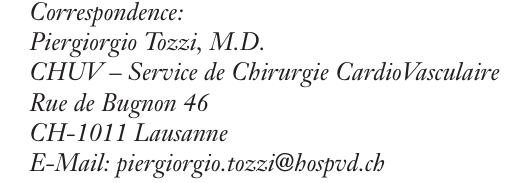
Inflow (dash line) and outflow (contin- uous line) through a 10 cm segment of pig carotid artery acquired simultane- ously. The difference between the two lines is the phase shift ( ϕ ) and it repre- sents the energy converted in the ves- sel wall deformation during blood dis-